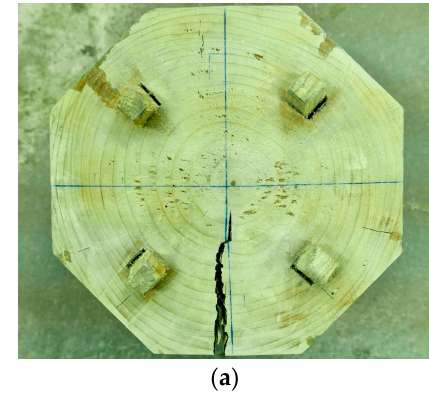
Figure 15. Failure modes of Zuo-Dou after rotational test: ( a ) deformation of wooden teeth, specimen No. 1; ( b ) wooden teeth as plastic hinge, specimen No. 1.